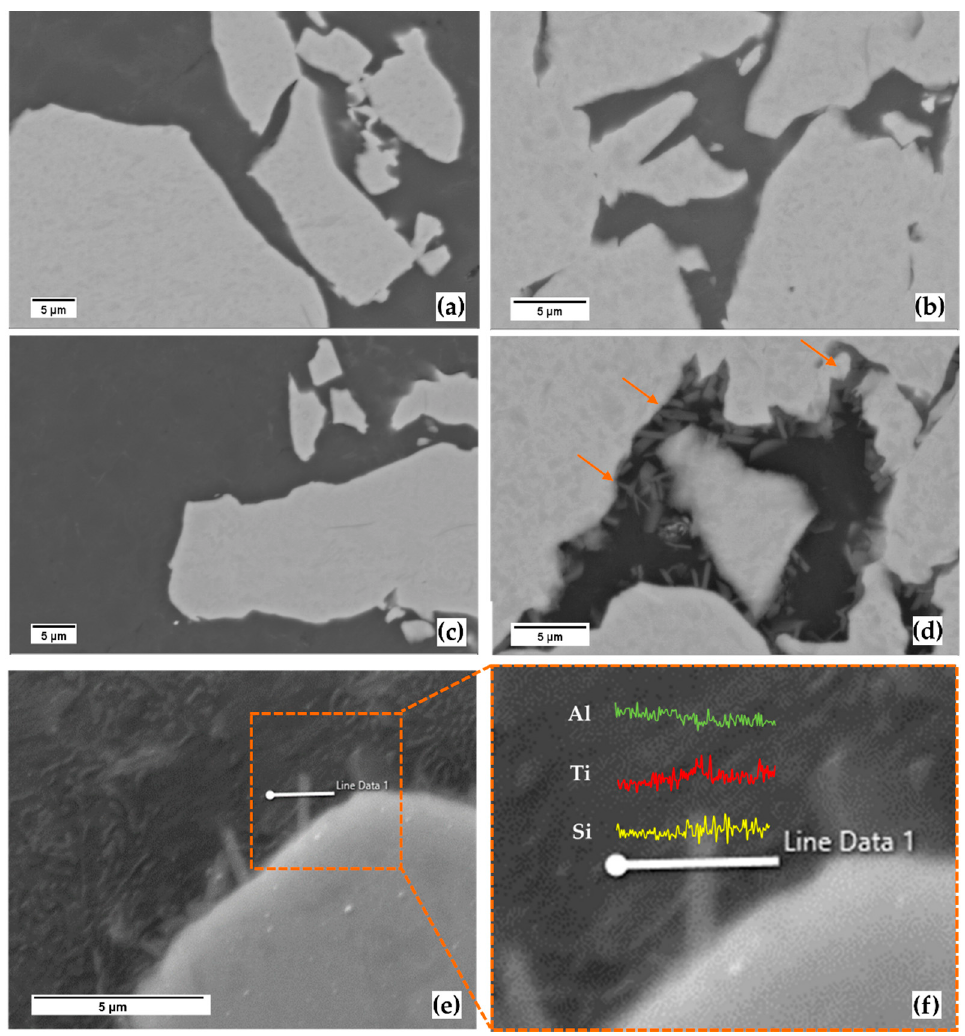
Figure 5. BSE-SEM micrograph of the ESFed samples. ( a , b ) micrographs are the low-energy samples, respectively, from the 20Ti-AlSi, and the 80Ti-AlSi powders mix, ( c , d ) are the high-energy samples, respectively, 20Ti-AlSi and 80Ti-AlSi, ( e , f ) are the result of an EDS analysis on an intermetallic particle. Orange arrows in ( d ) underline the presence of needle-shaped particles in AlSi10Mg isles. Table 2. Composition after EDS point analysis of the reacted layer.